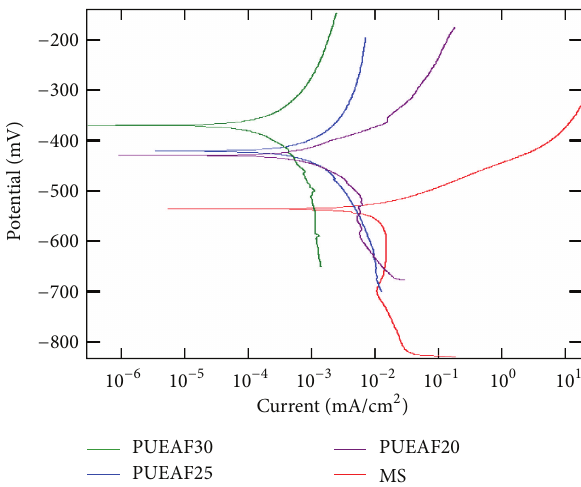
Figure 8: Tafel plots of bare MS and PUEAF coated MS in 5% NaCl